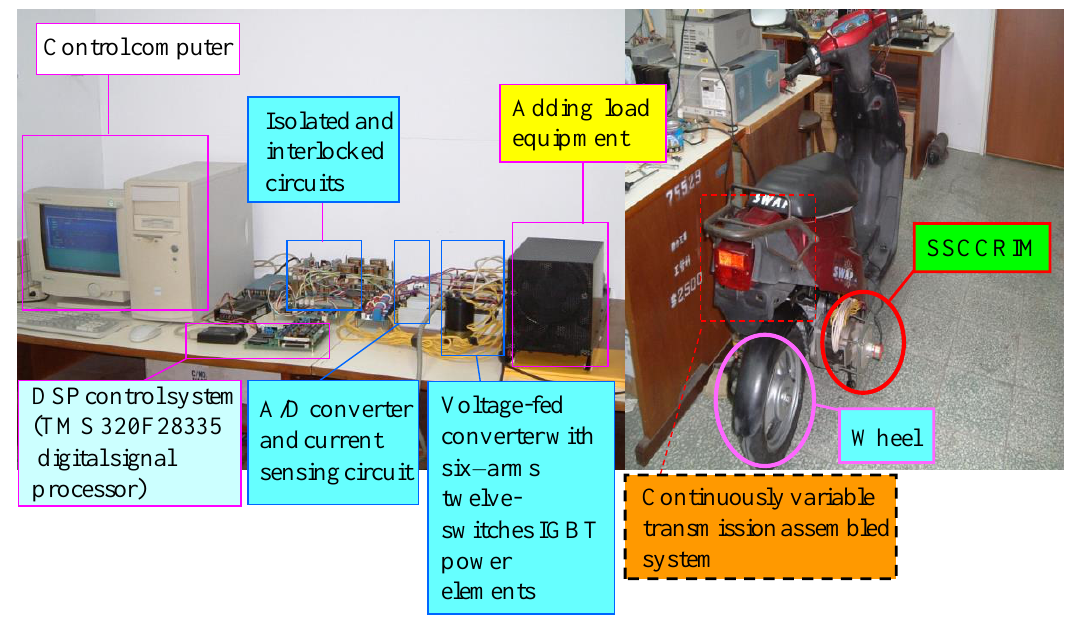
Figure 15. A photo of the test rig and experimental setup.